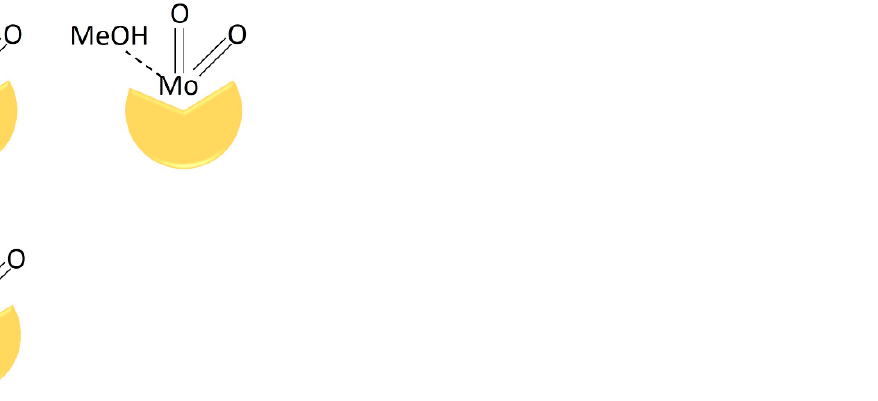
Scheme 2. Presentation of the oligomeric Mo complexes ( left ) and monomeric Mo complexes ( right ). Ligands H 2 L H, 3OMe and 4OMe employed for the catalyst preparation are presented with the yellow partial circle. Polymerization mode through a terminal oxygen atom, occurring in the oligomeric complexes, is presented by the dashed purple line.